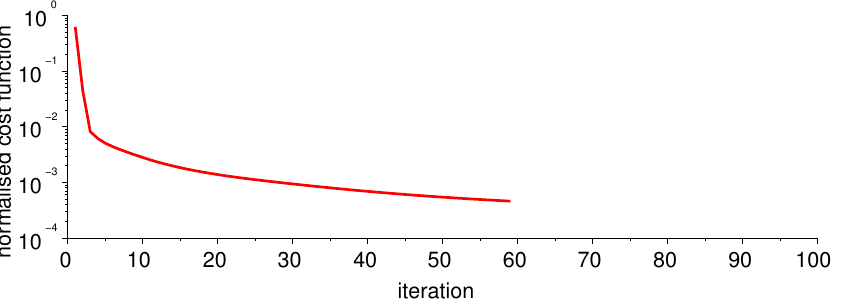
Figure 3. An example of the QNN’s training